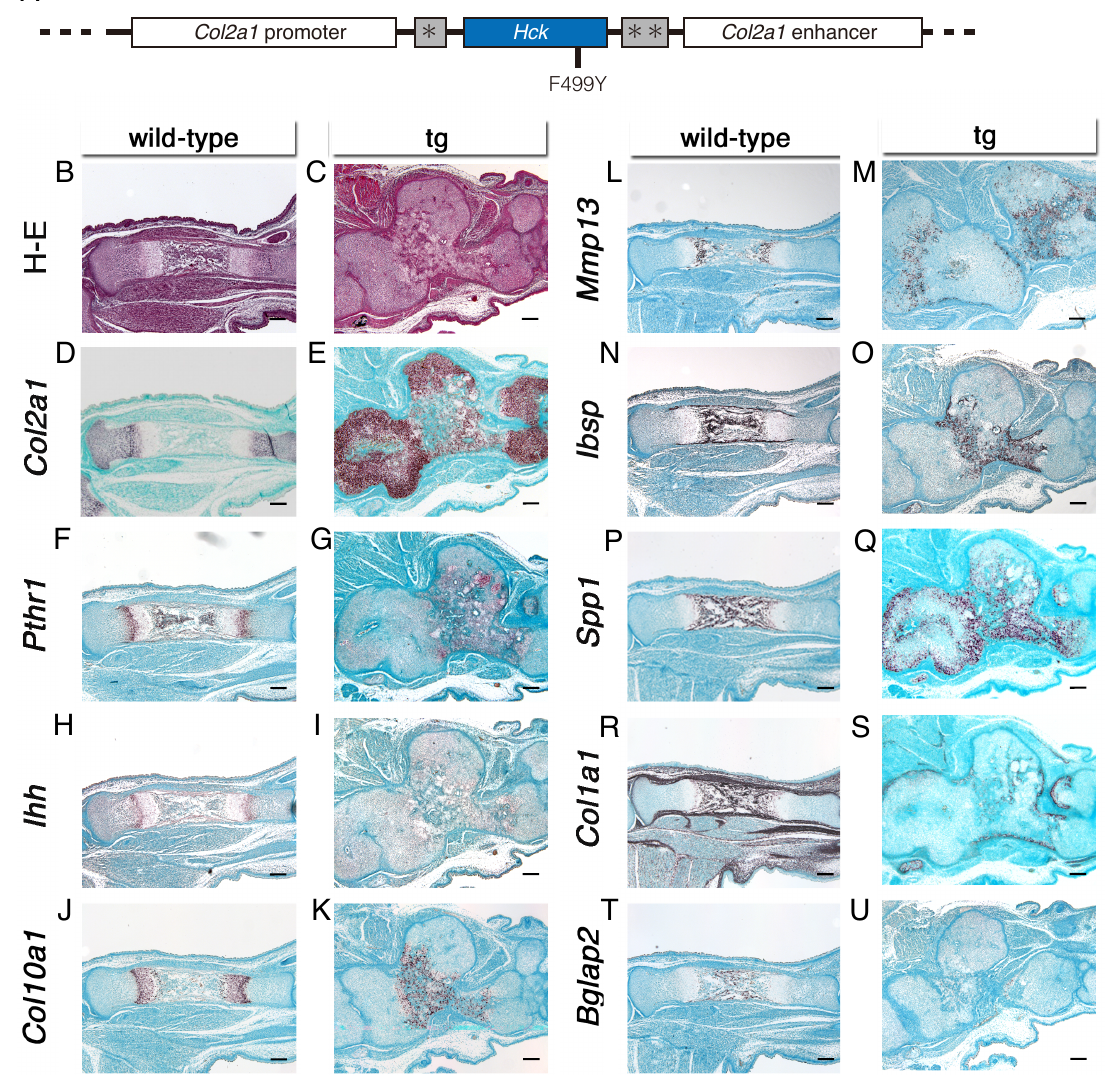
Figure 2. Histological analyses of tibiae in Hck CA tg embryos at E16.5. ( A ) Diagram of the DNA construct used to generate tg embryos that express Hck CA under the control of the mouse Col2a1 promoter-enhancer. The tyrosine at amino acid 499 was substituted with phenylalanine in Hck CA . * Intron from rabbit β -globin gene, ** Polyadenylation signal from SV40. ( B , C ) Hematoxylin and eosin ( H – E ) staining of wild-type and Hck CA tg embryos. ( D – U ) In situ hybridization using Col2a1 ( D , E